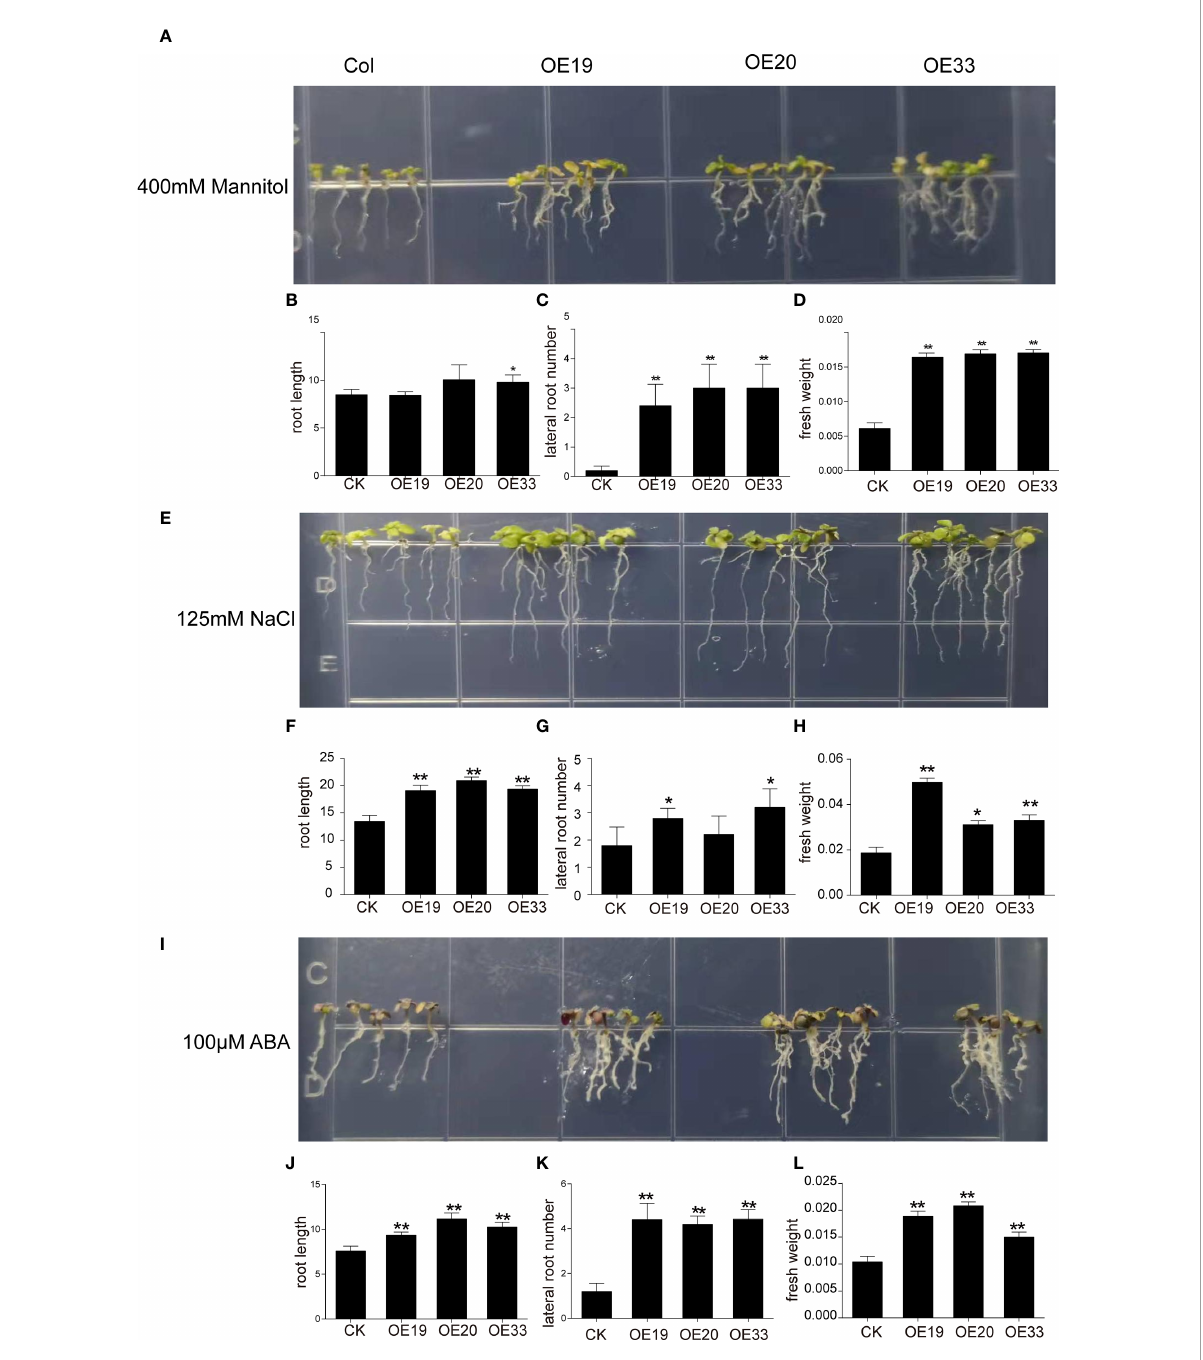
FIGURE 7 Evaluation of different resistance of MfERF053 transgenic Arabidopsis . (A, E, I) , Plants overexpression MfERF053 were treated with 400 mM mannitol, 100 mM NaCl and 100 m M ABA with wide type, respectively. (B, F, J) , Root length of different plant lines. (C, G, K) , Lateral root number of different plant lines. (D, H, L) , Fresh weight of different plant lines. Three replicates per treatment, 6 plants per replicate, * p < 0.05, ** p < 0.01, Duncan ’ s t